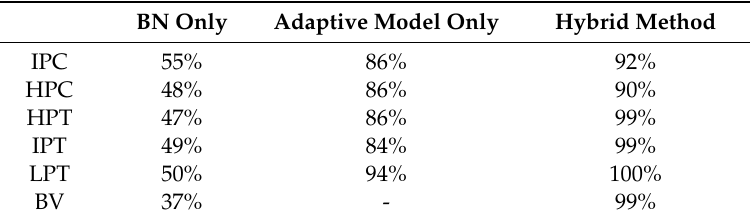
Table 9. Detection and isolation accuracy in di ff erent flight